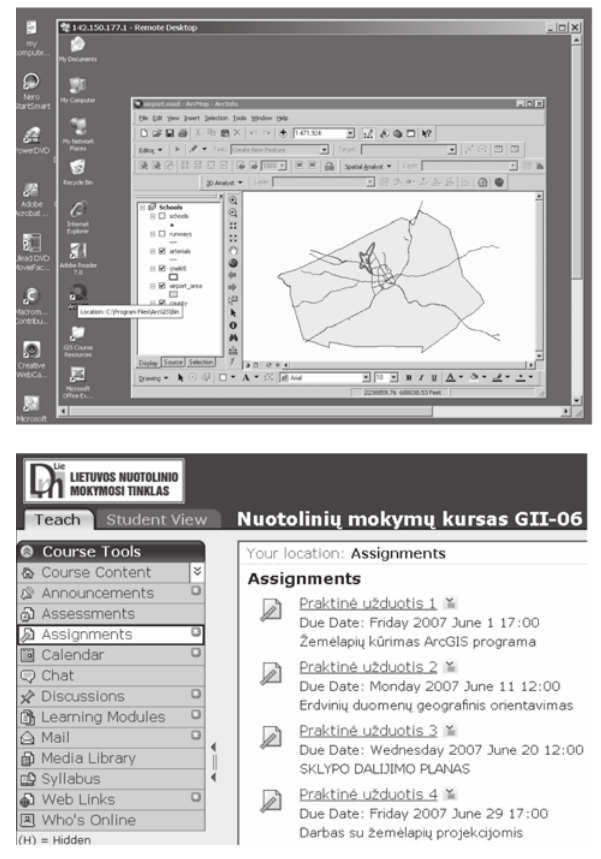
Fig. 3. Access to assignment page on the student learning portal and GIS software through a remote